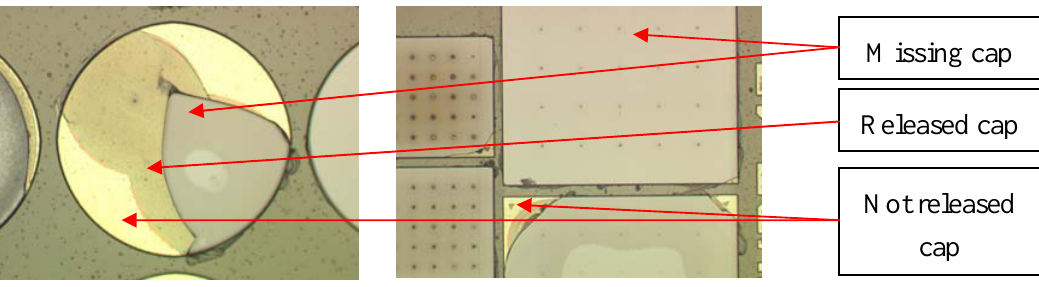
Figure 10. Cracked wafer level thin film packages during wafer